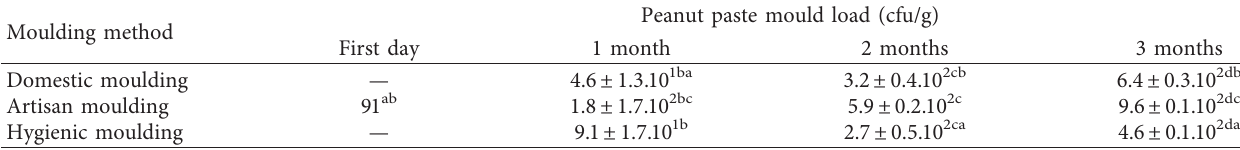
Table 2: Evolution of the mould load of peanut paste samples during storage according to the method of moulding.